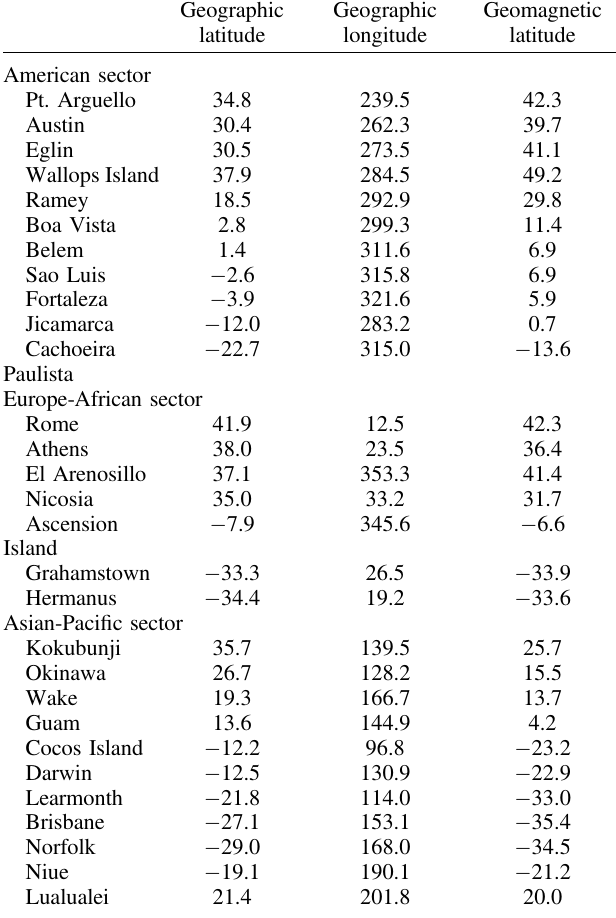
Geographic Geographic Geomagnetic latitude longitude latitude